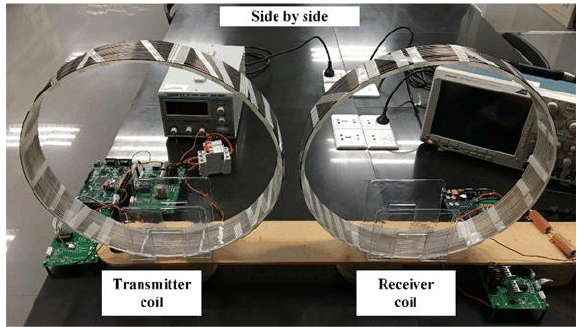
Figure 11. Experimental setup configuration. Table 1. Parameters of the experimental MCR-WPT system.